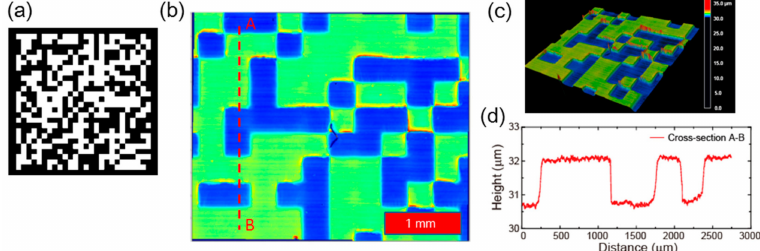
Figure 6. ( a ) Binary irradiation pattern, ( b ) top view and ( c ) three-dimensional image of the patterned PVA film, and ( d ) cross-sectional distribution of the volume